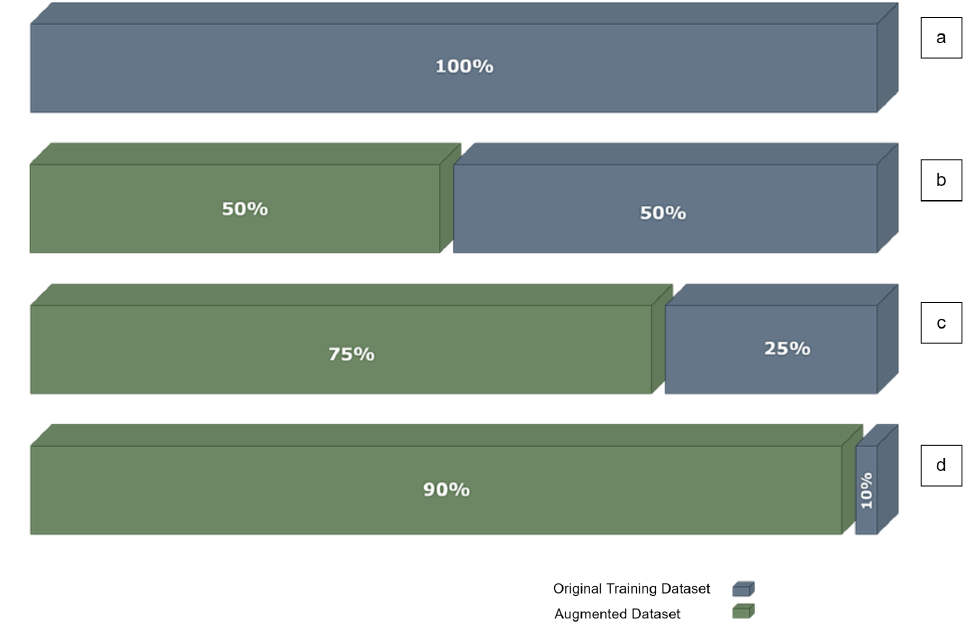
Figure 11. ( a ) Training dataset TDS. ( b ) TDS/2: 50% of the training dataset and 50% augmented data. ( c ) TDS/4: 25% of the training dataset and 75% augmented data. ( d ) TDS/10: 10% of the training dataset and 90% augmented